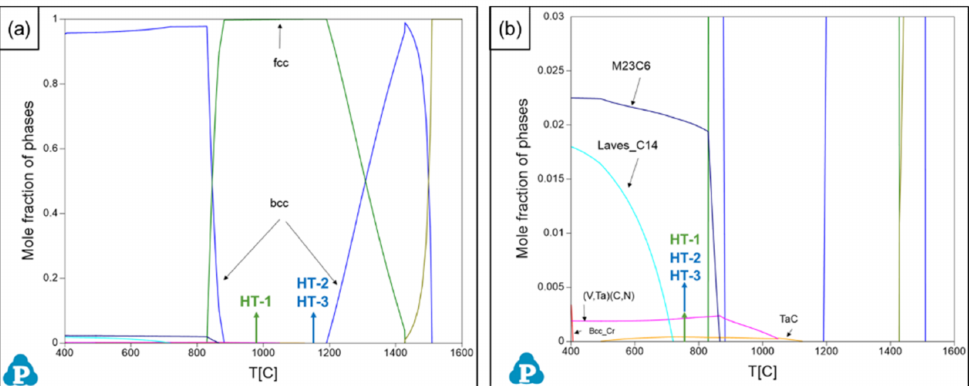
Figure 7. Results from Pandat calculations demonstrating the expected microstructure after heat treatments with different scales of the y -axis. Normalization temperatures are shown in ( a ) and tempering temperatures are shown in ( b ).